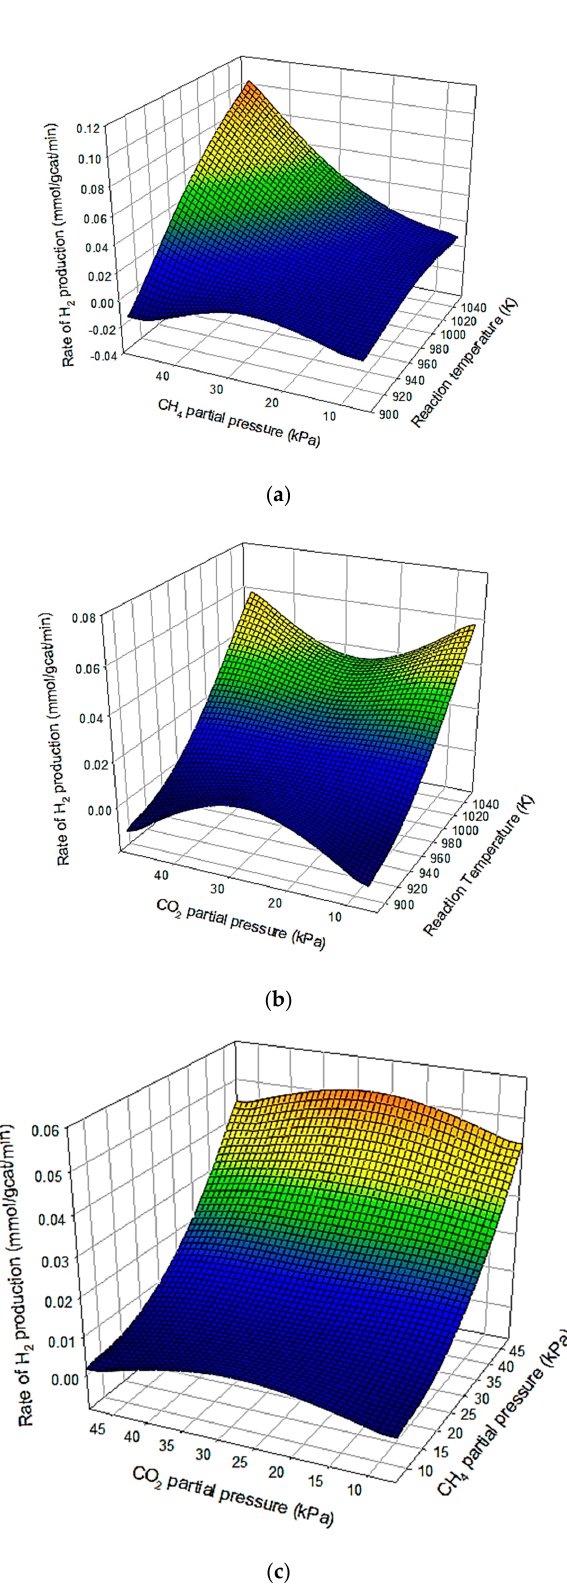
Figure 1. ( a ) Interaction e ff ect of CH 4 partial pressure and reaction partial pressure on the rate of CO production; ( b ) Interaction e ff ect of CO 2 partial pressure and reaction temperature on the rate of CO production; ( c ) Interaction e ff ect of CH 4 partial pressure and CO 2 partial pressure on the rate of CO